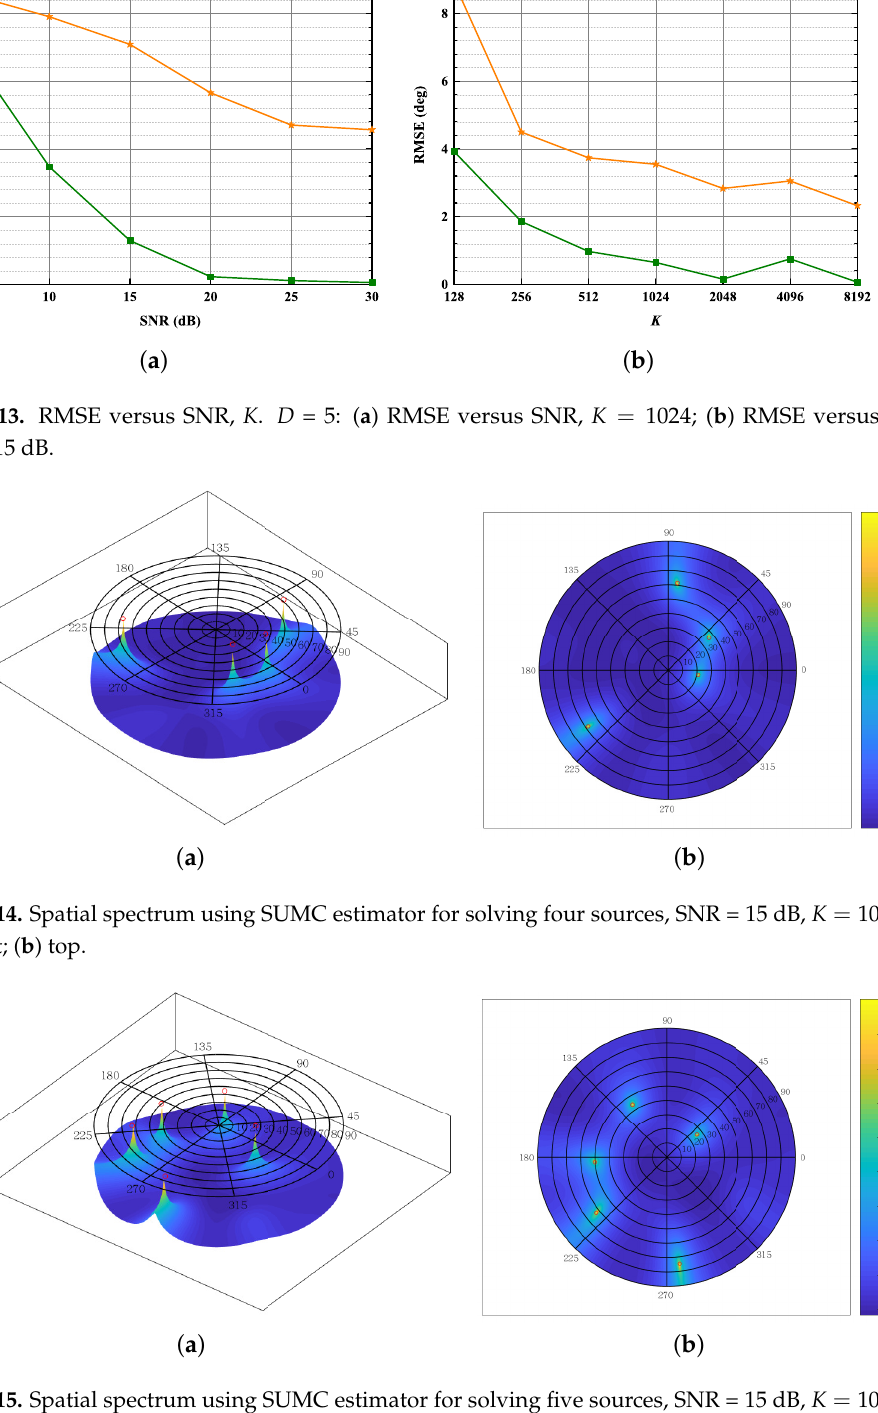
Figure 15. Spatial spectrum using SUMC estimator for solving five sources, SNR = 15 dB, K = 1024: ( a ) front; ( b )